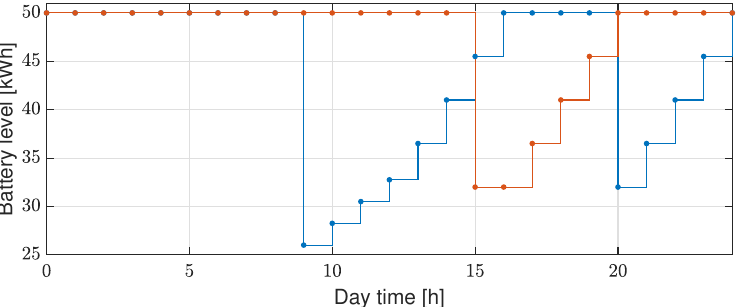
Figure 3. Example 1. Battery level s d , t of vehicles 1 (blue) and 2